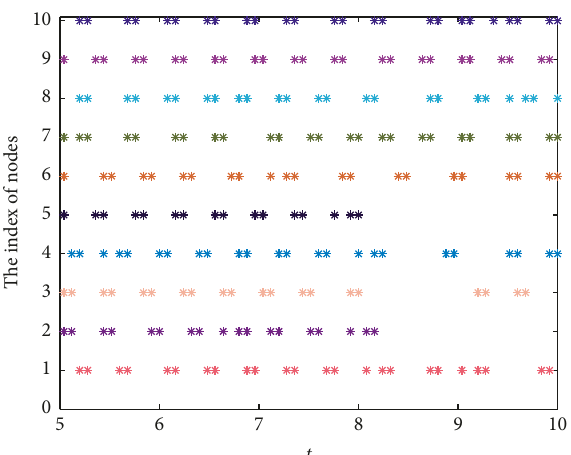
Figure 11: The events of each node with θ